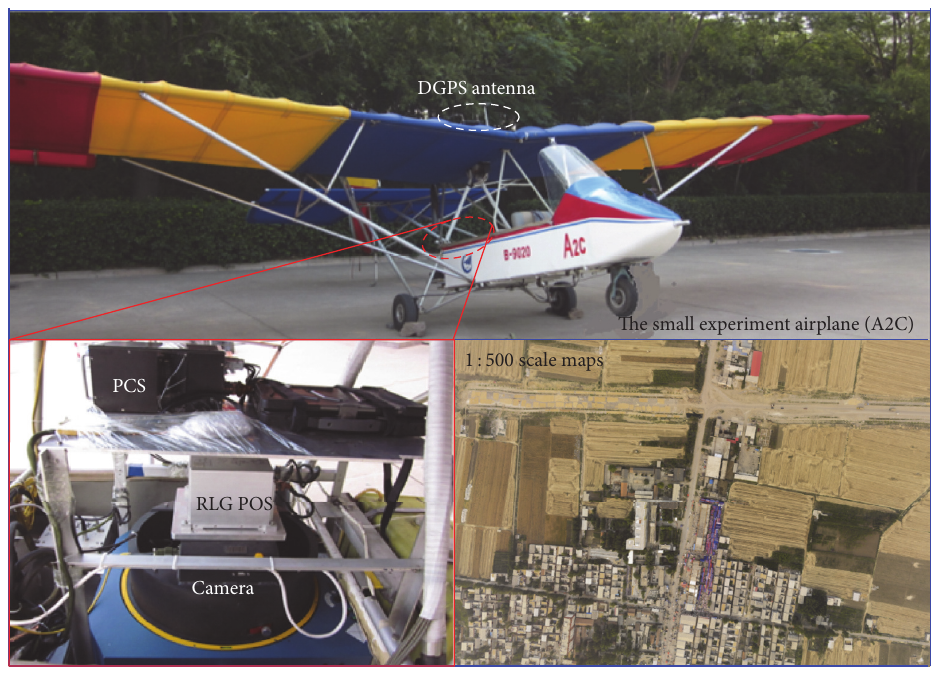
Figure 5: The mapping experiment of camera integrated RLG POS.